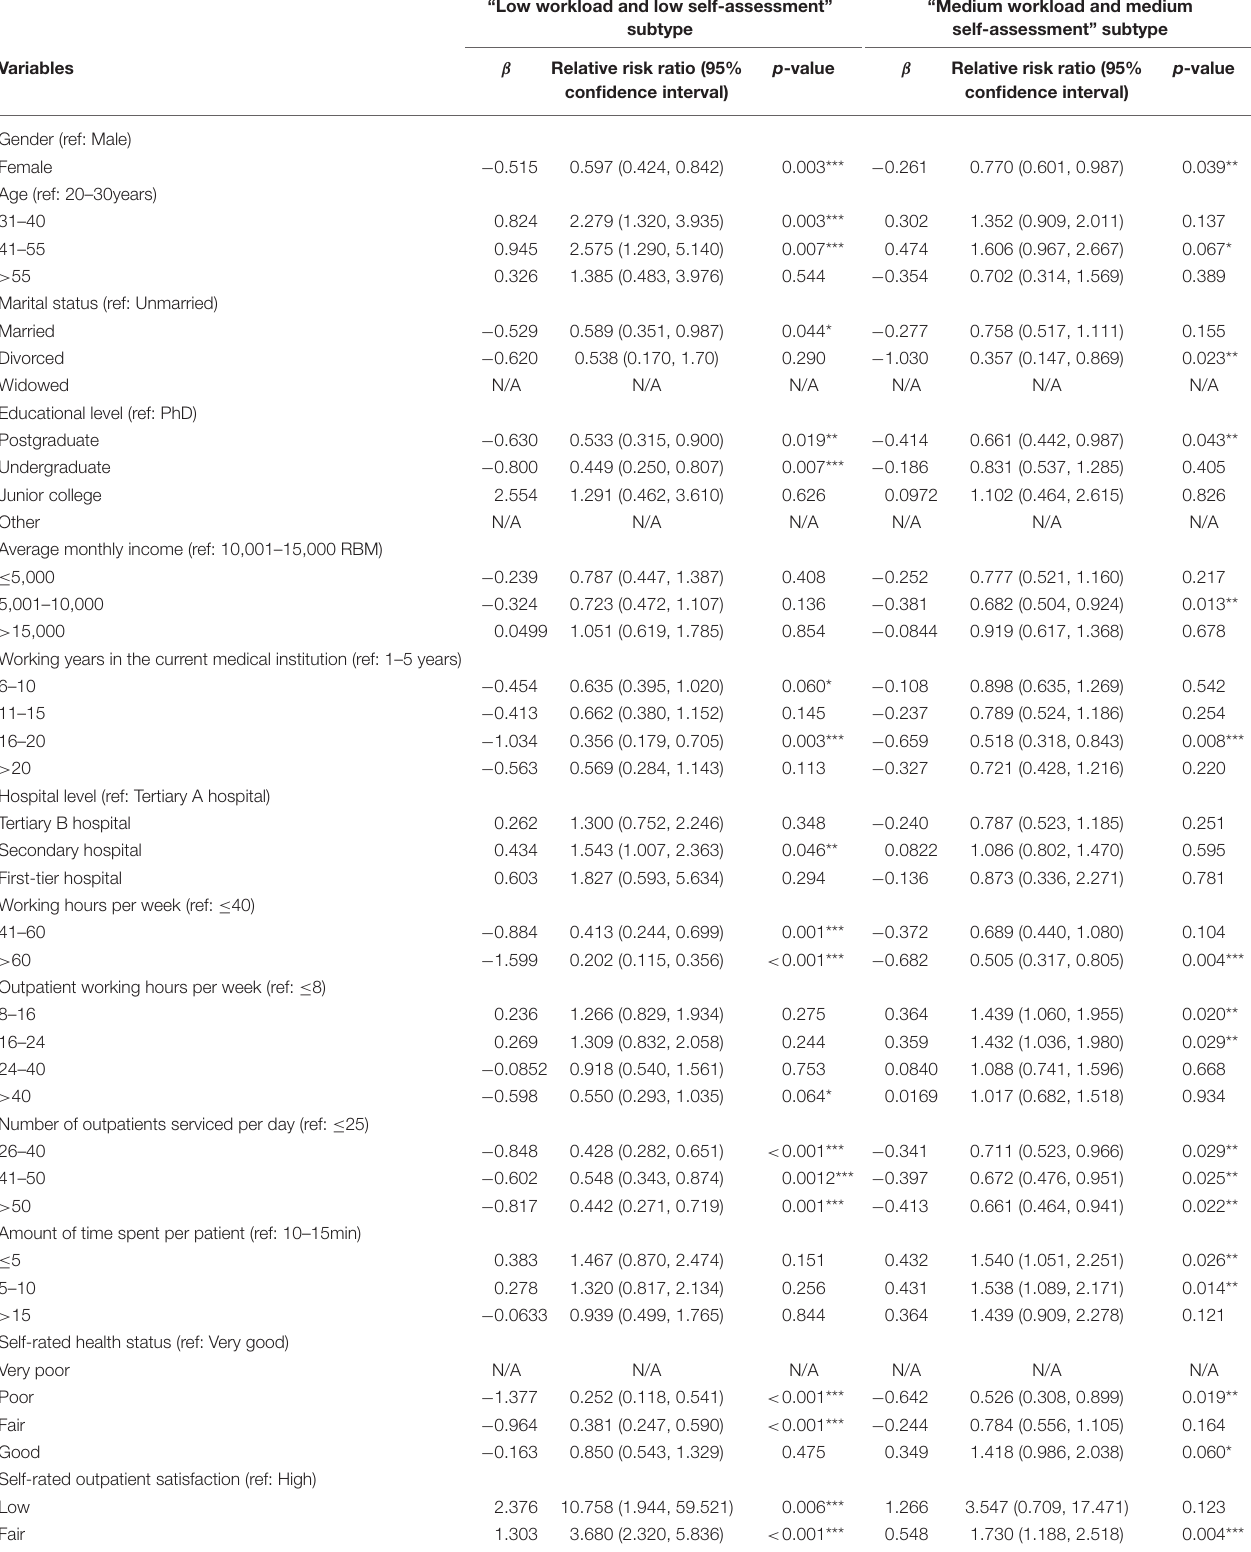
TABLE 5 | Multinomial logistic regression results: significant determinants of the subtypes of physicians in mental workload.